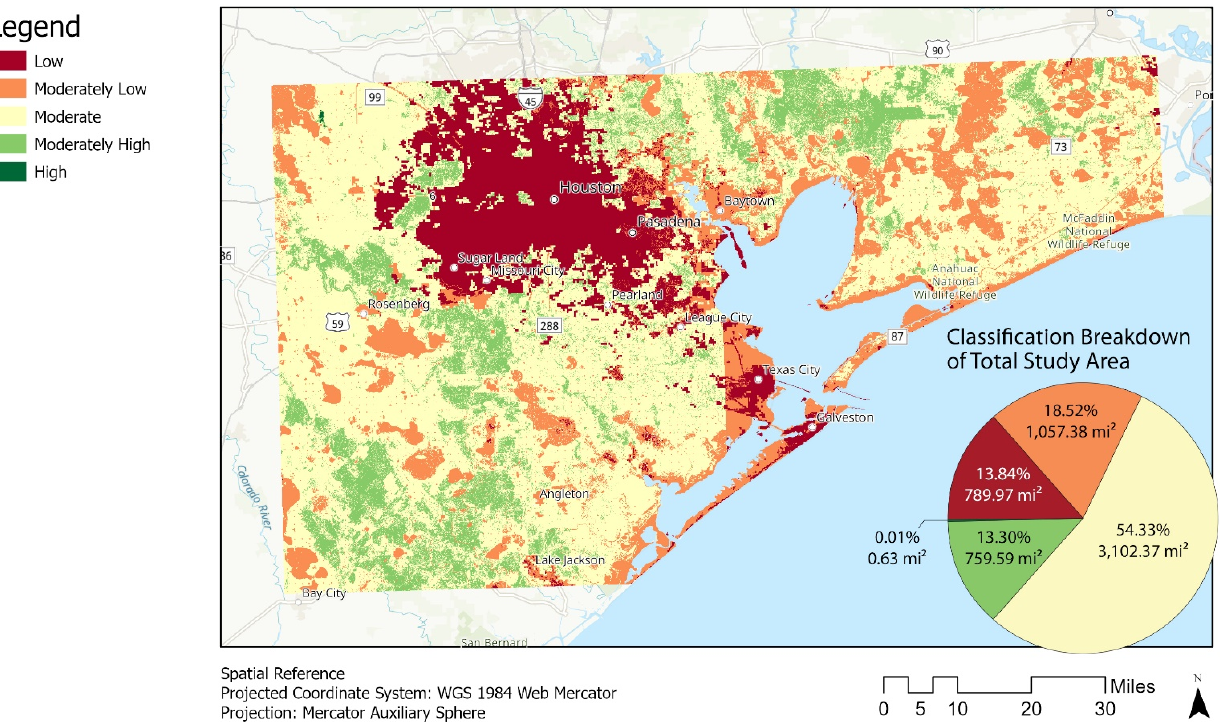
Figure 3. Nature-based service level outputs and their classification’s area in square miles and percent of total area of the study area derived from the number of services provided for the Houston-Galveston study area of 30° N to 29° N (north to south boundary) and 96° W to 94° W (west to east boundary).